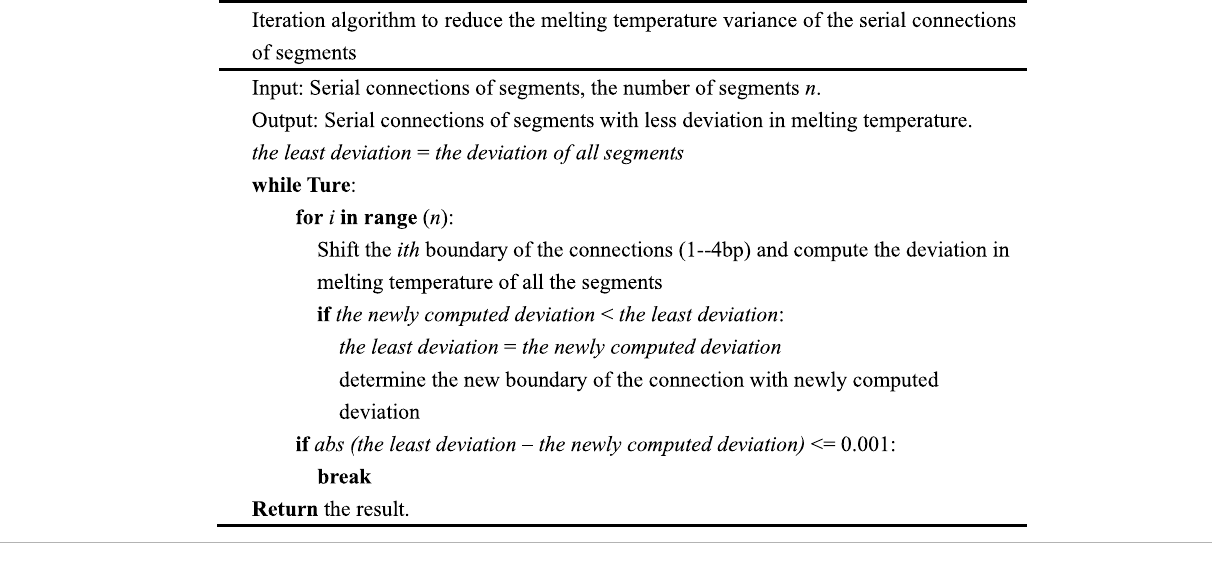
TABLE 2 | The iteration algorithm.